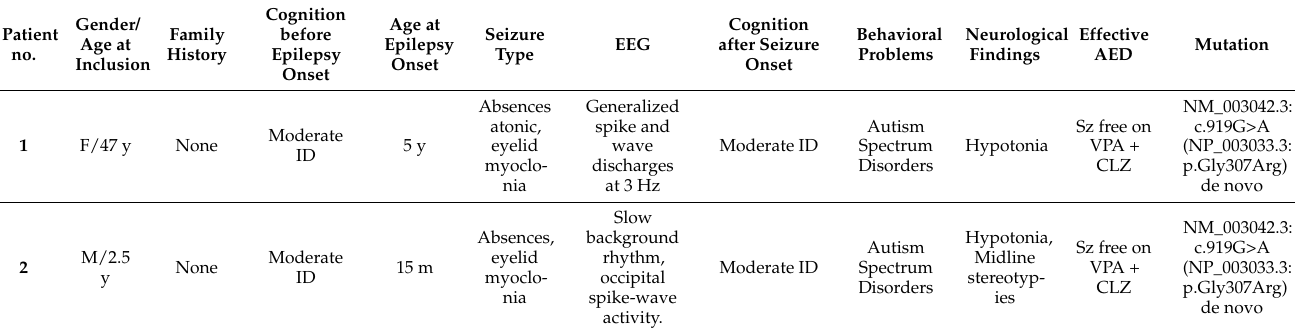
Table 1. Clinical characteristicsof patients included in this